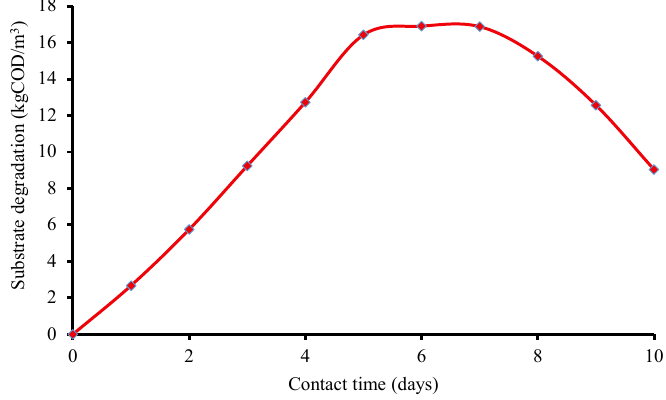
Fig. 8: Substrate degradation corresponding to the power production in MFC